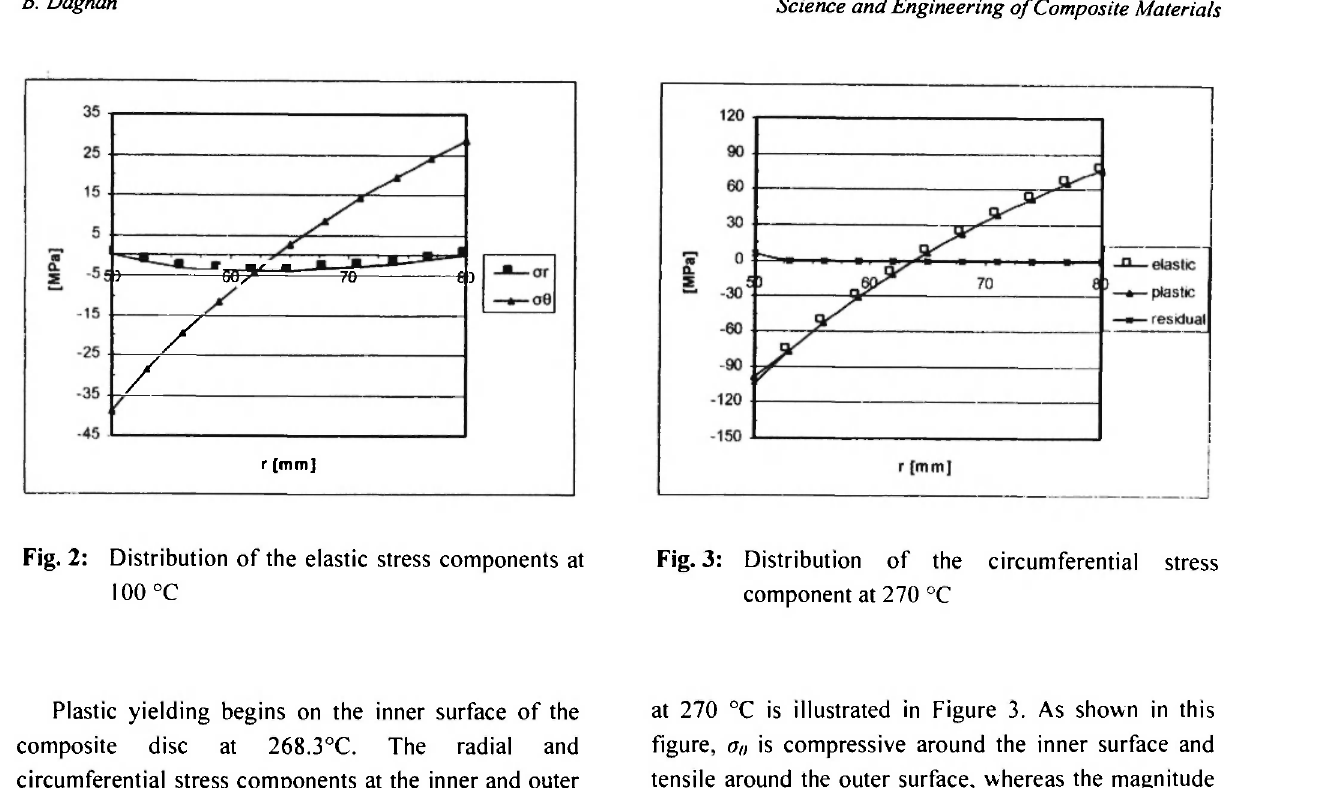
Fig. 3: Distribution of the circumferential stress component at 270